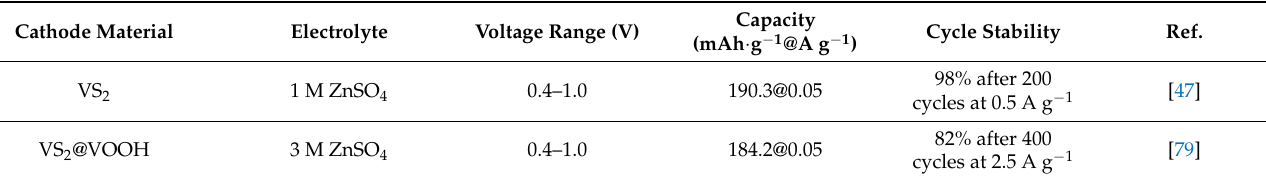
Figure 8. Timeline for the development of vanadium-based sulfides as cathode materials for AZIBs. Table 2. Summary of electrochemical performance of vanadium sulfide cathode materials in AZIBs.